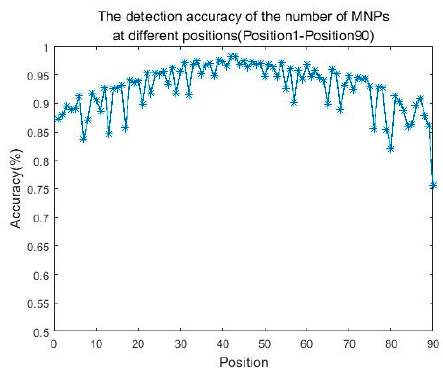
Figure 13. The detection accuracy of the number of MNPs at Position1–Position90.